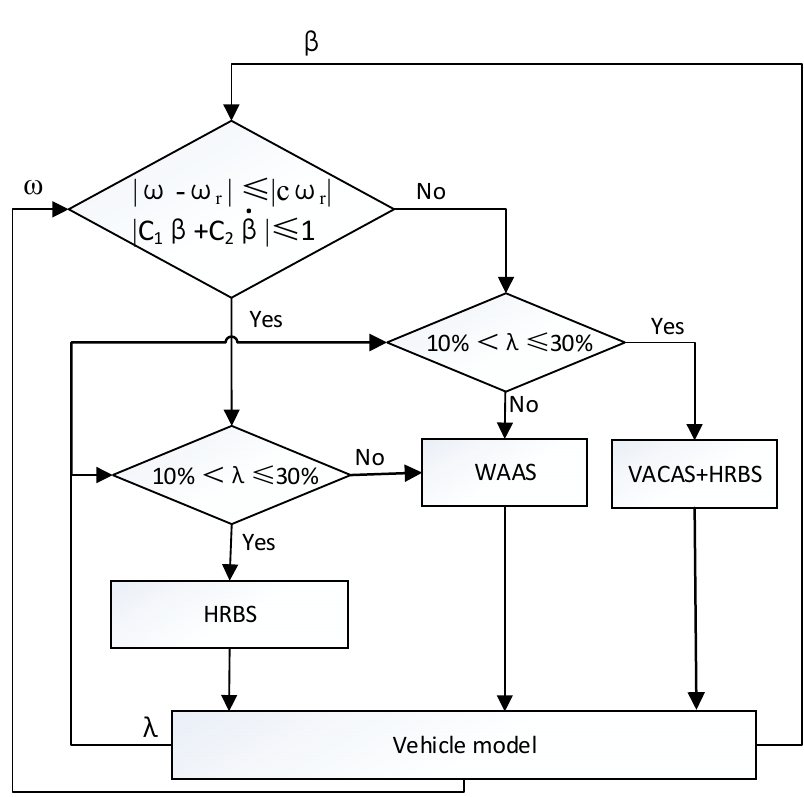
Figure 11. Cooperative control strategy of HRBS based on chassis domain control .